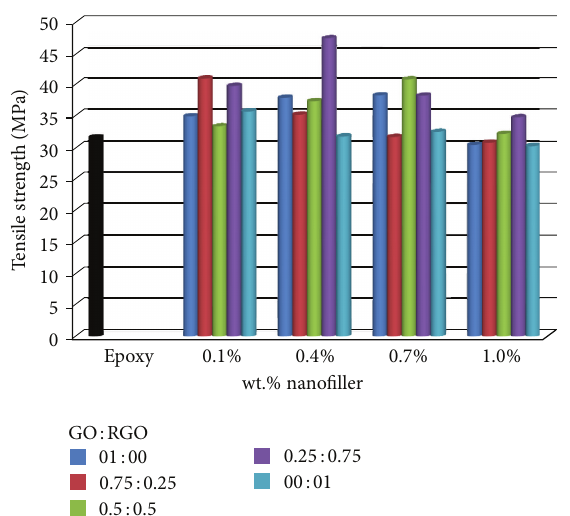
Figure 5: Tensile strength of nanocomposites reinforced with graphene oxide (GO), reduced graphene (RGO), and different combinations of both nanofillers.